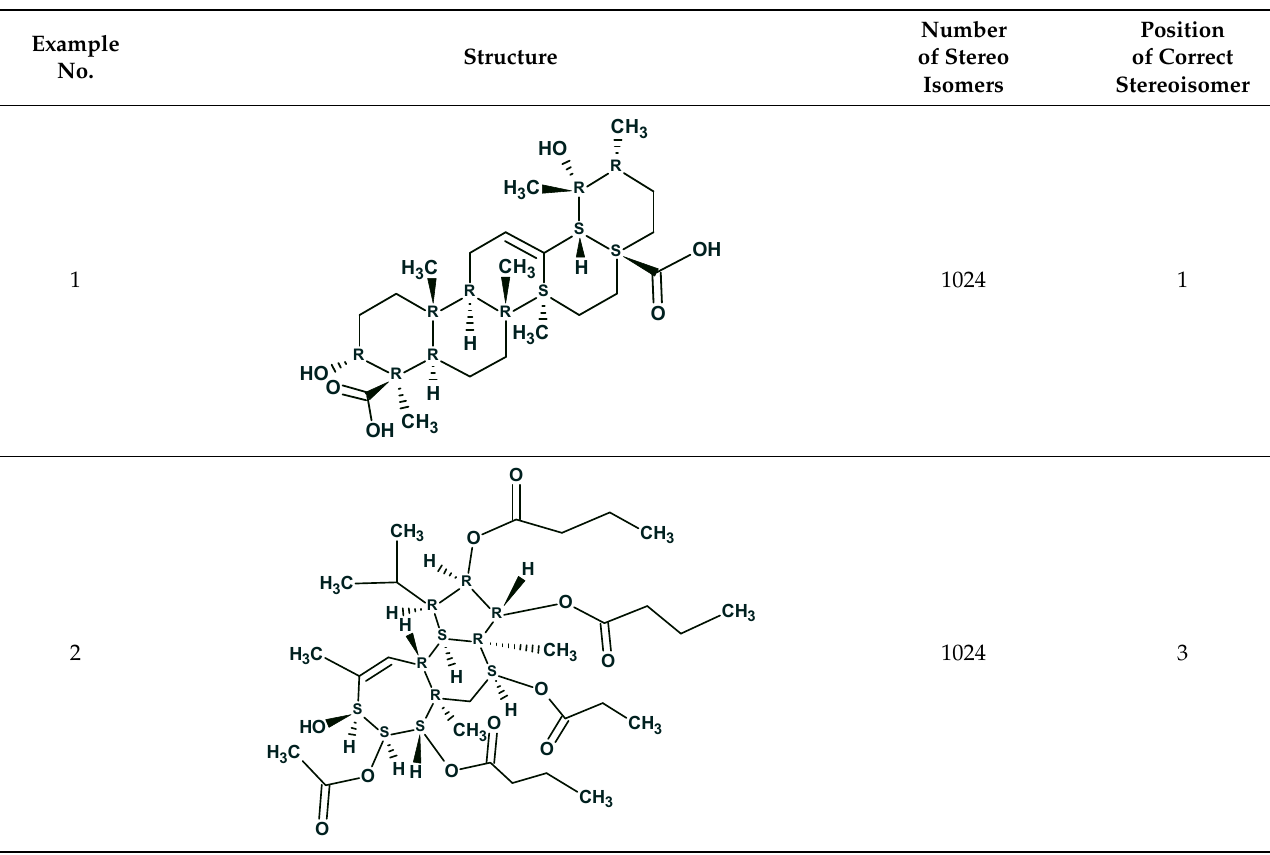
Table 2. Examples of structures for which sets of preferable stereoisomers were selected using empirical methods of 13 C NMR chemical shift prediction.